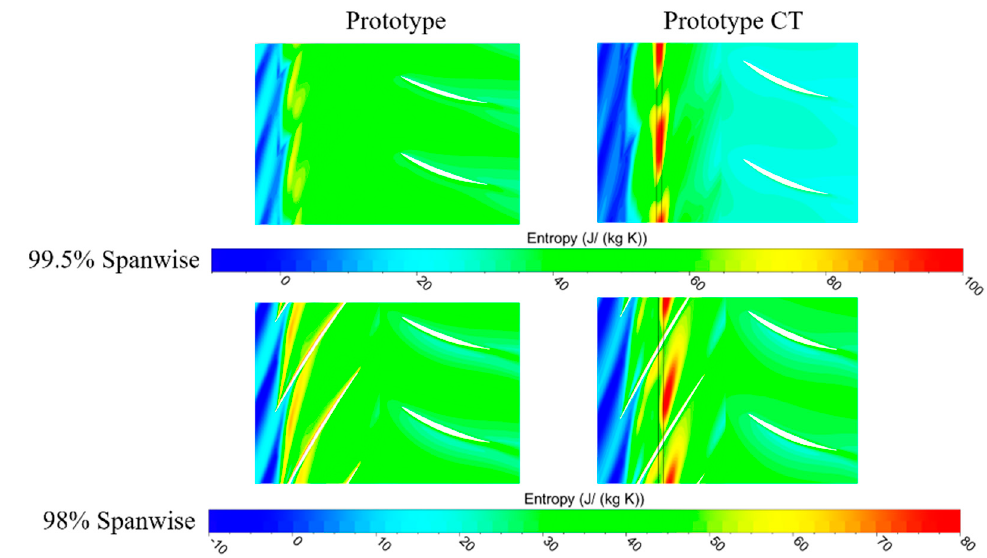
Figure 19. Entropy distributions at 99.5% and 98% spanwise.